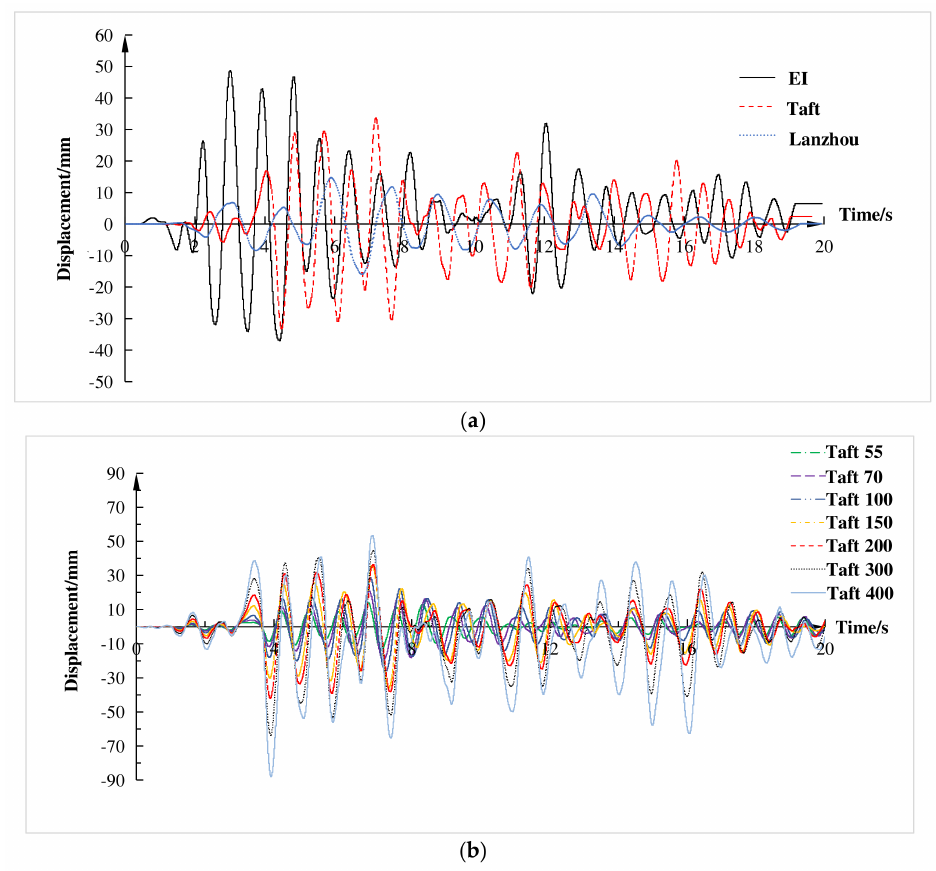
Figure 9. Time history curves of top displacement. ( a ) Input peak acceleration is 200 gal; ( b ) Taft